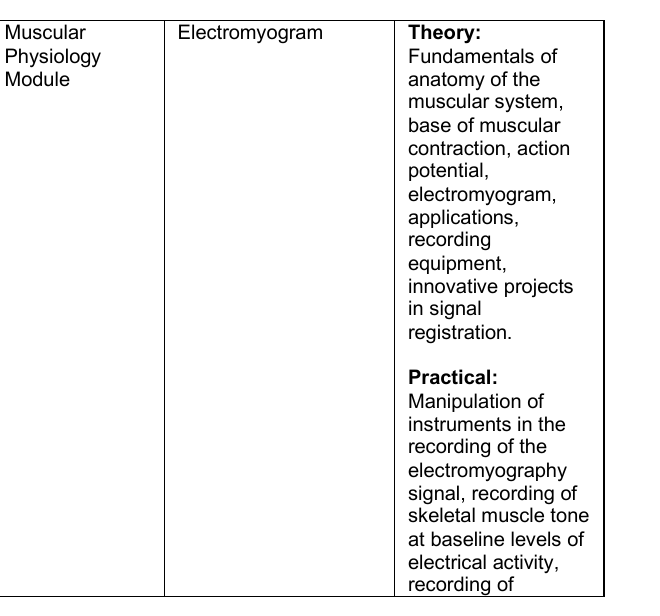
Table 2. Key objectives of the new course